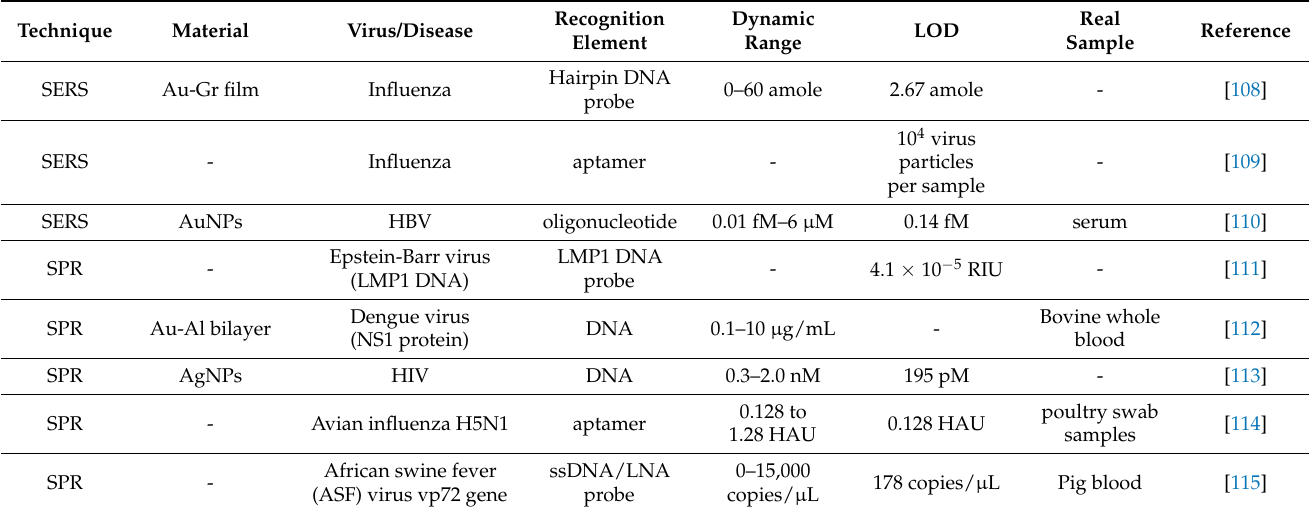
Table 3. List of the Surface-Enhanced Raman Spectroscopy (SERS), Surface Plasmon Resonance (SPR)-based biosensors for virus